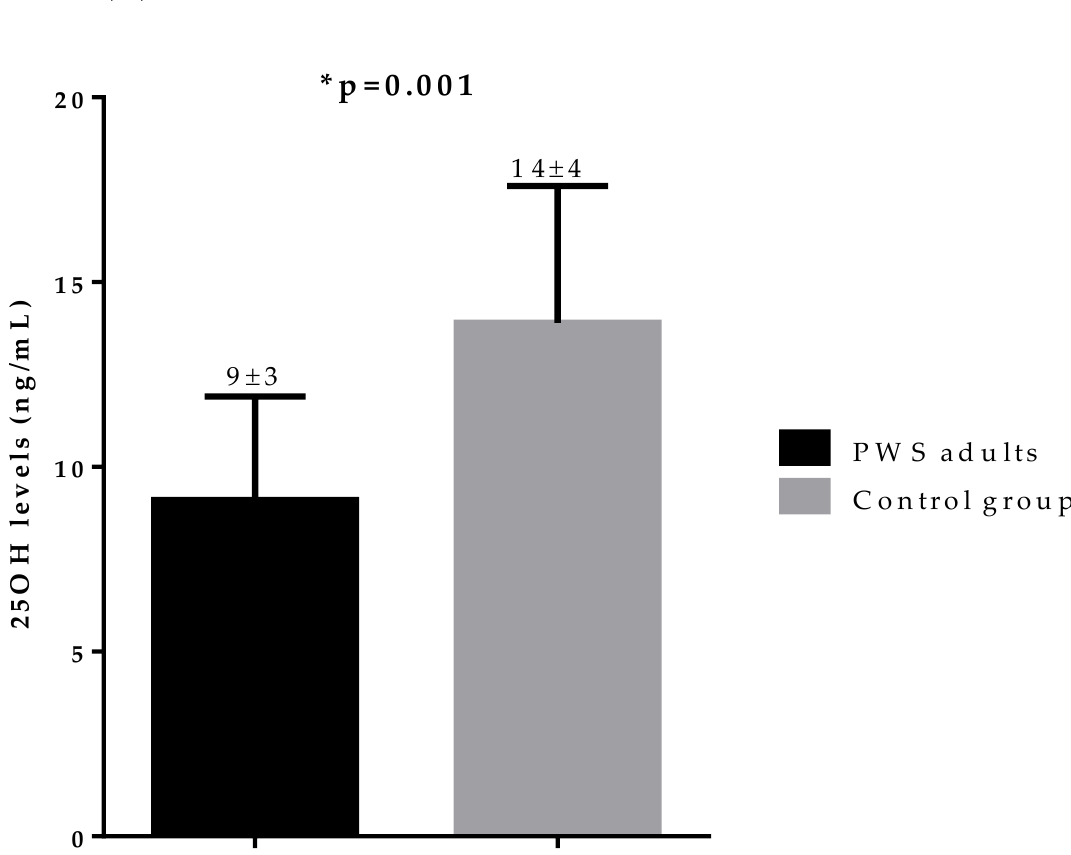
Figure 1. Difference in 25OHD levels in PWS adults and the control group. PWS adults showed lower 25OHD levels compared to matched controls (9 ± 3 vs 14 ± 4 ng/mL, p = 0.001). * A p value < 0.05 means a significant difference. PWS, Prader–Willi syndrome.